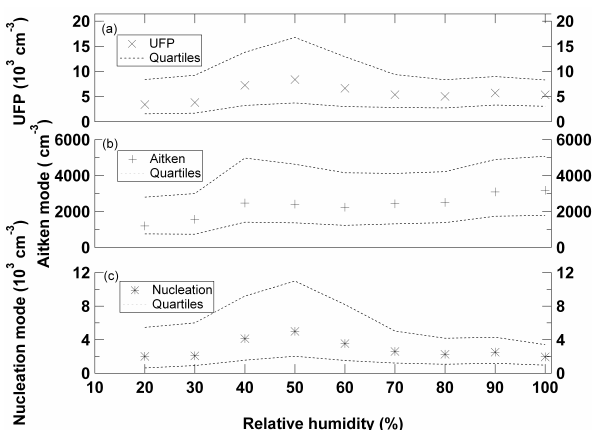
Fig. 3. Diurnal variation of (a) averaged solar radiaiton, (b) aver- aged wind direction/speed, (c) averaged temperature and RH, and (d) averaged UFP, nucleation mode and Aitken mode particle con- centrations.